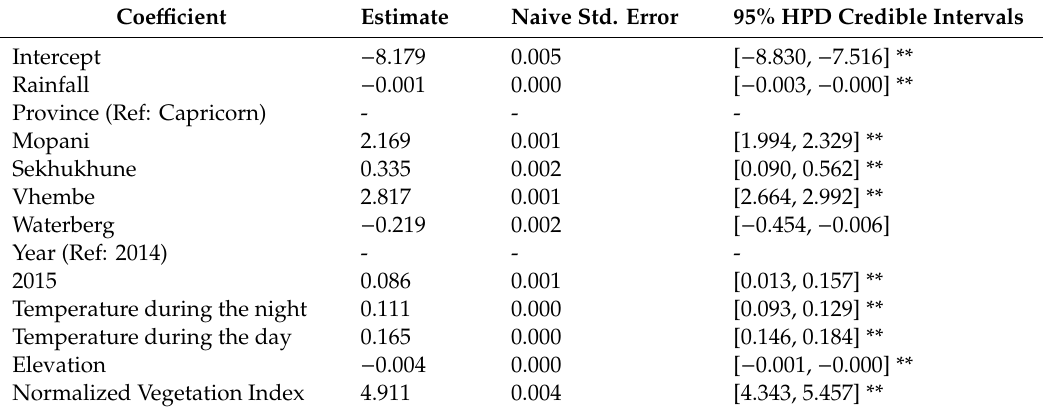
Table 5. Parameter estimates for negative binomial (NB) model with Bayesian approach encompassing all the